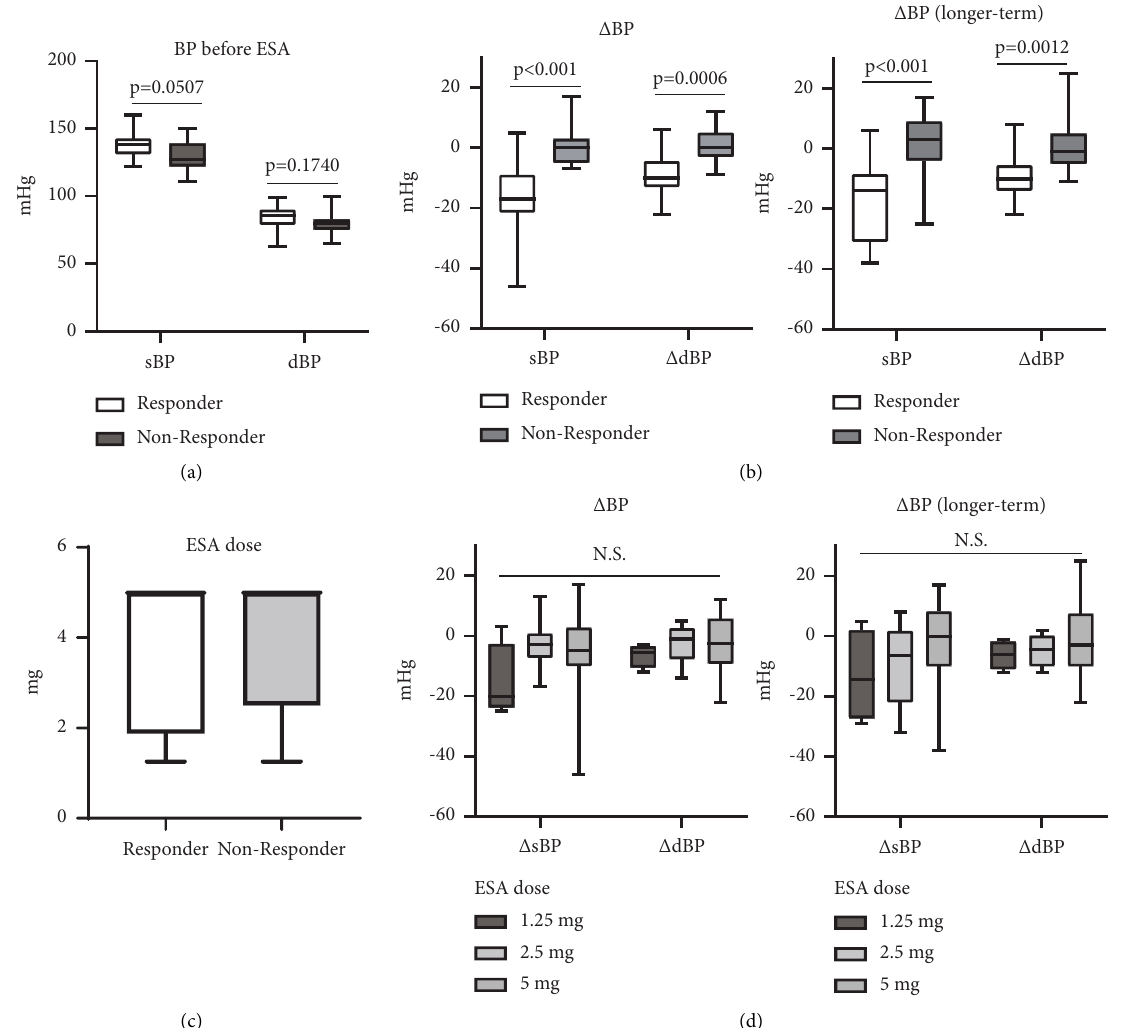
Figure 1: Blood pressure (BP) and doses of 13 responders and 19 nonresponders. (a) Systolic blood pressure (sBP) and diastolic blood pressure (dBP) before the introduction of esaxerenone (ESA) in each group (responder: white and nonresponder: grey bars). (b) BP changes after ESA introduction. Delta-BP ( Δ BP) was calculated as the diference in sBP and dBP before and after treatment for each subject. (c) Dose of introduced ESA in each group. (d) Changes in sBP and dBP in each dose of esaxerenone. Each bar graph and error bar represent the mean ±